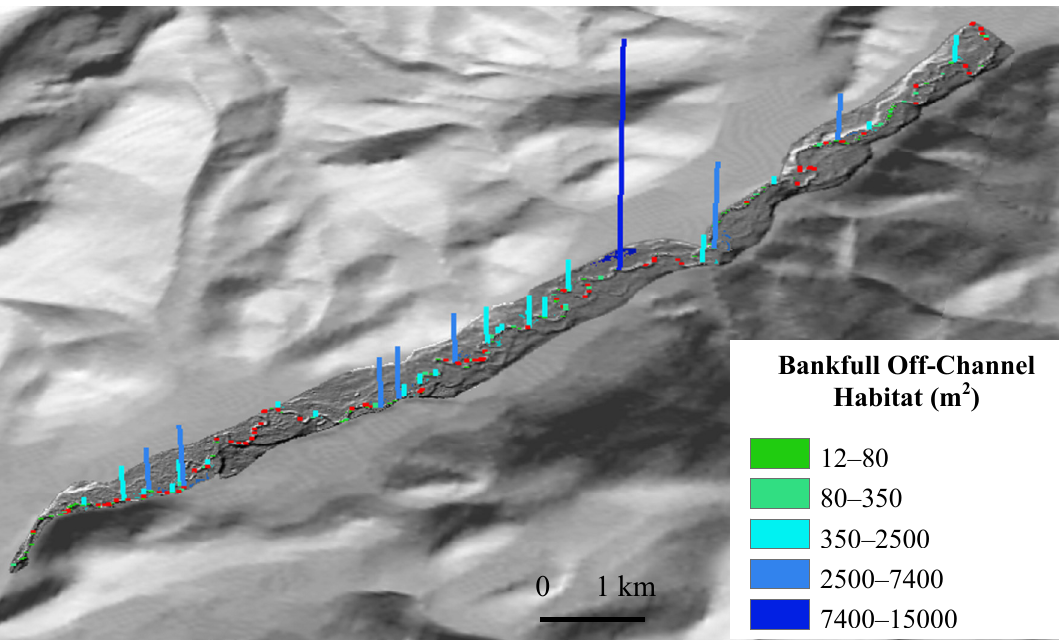
Figure 13. Histogram of distribution of off-channel habitat that is hydraulically connected to the main channel at bankfull flow conditions. Histogram bars show the area of off-channel habitat connected to each 300 m reach of the 10 km stream